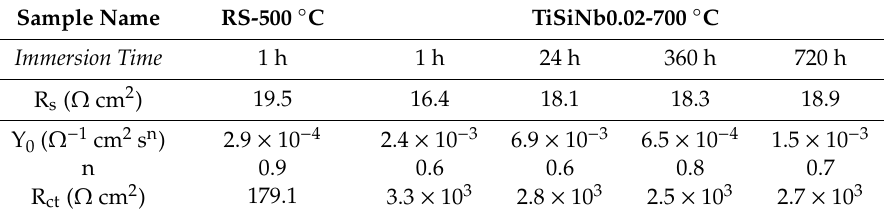
Table 4. EIS fitting parameters of annealed RS at 500 ◦ C and TFSOC at 700 ◦ C after immersion in SCS.